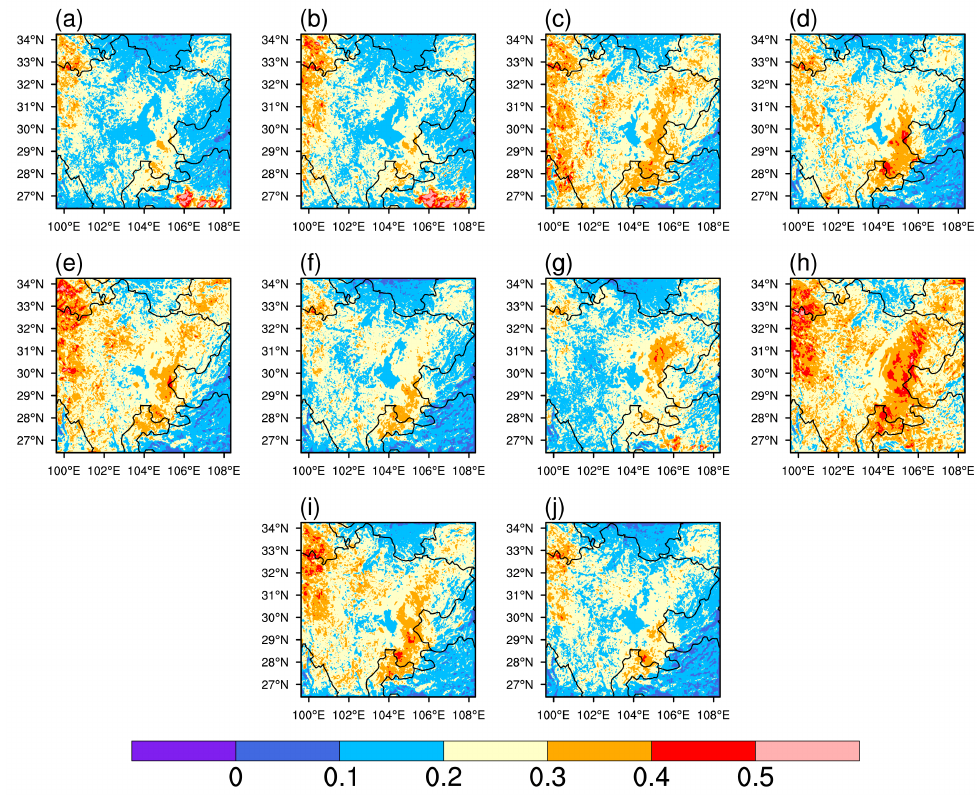
Figure 18. Spatial distribution of STD values for 12-h averaged 2-m temperature (K) during 12:00– 23:00 UTC. Panels from ( a – j ) stand for P1 to P10,